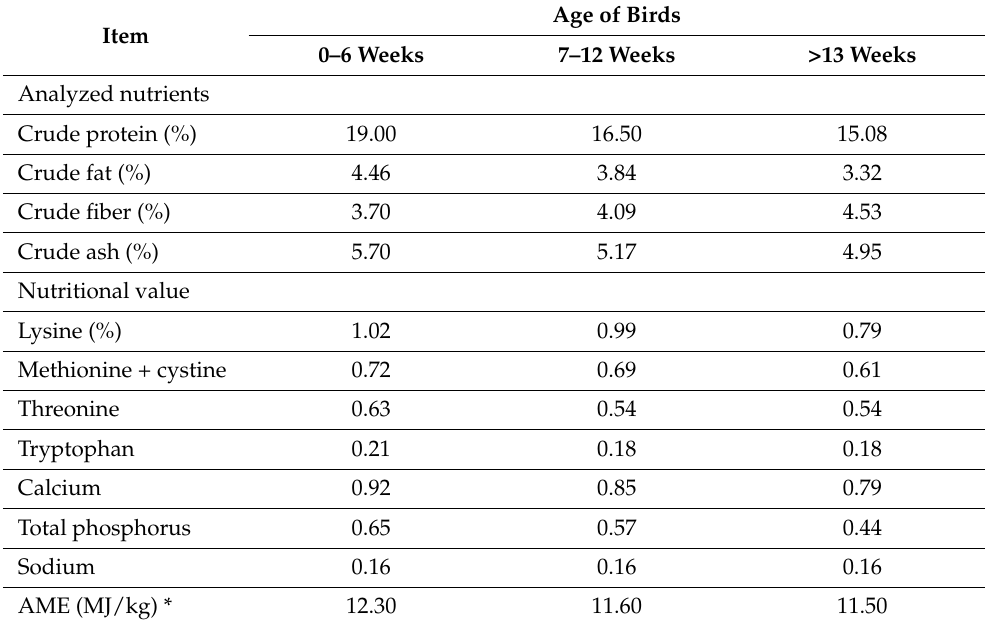
Table 1. The composition of feed mixture dedicated for guinea fowl depending on the birds’